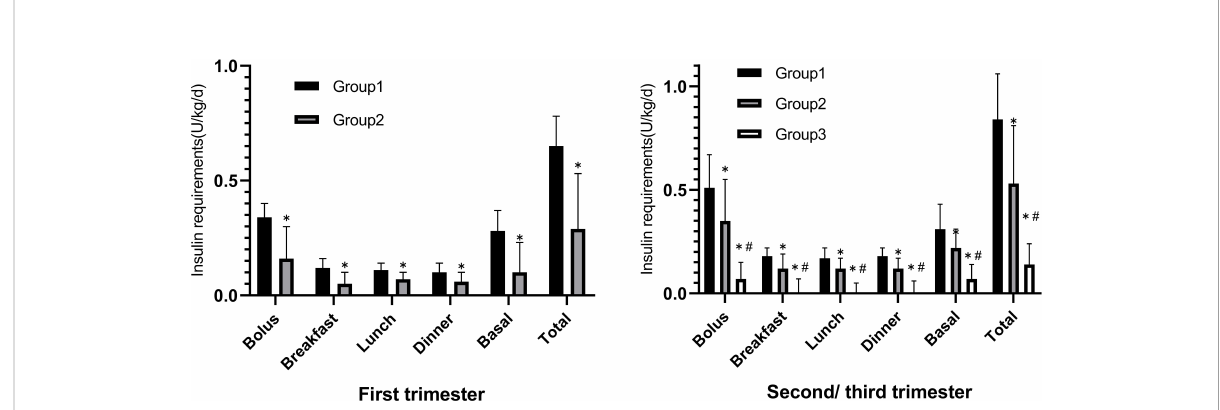
FIGURE 2 The comparison of daily Insulin dosage (U/kg/day) distribution of the three groups in the fi rst trimester versus the second/third trimester. *p < 0.05 compared to Group 1, # p < 0.05 compared to Group